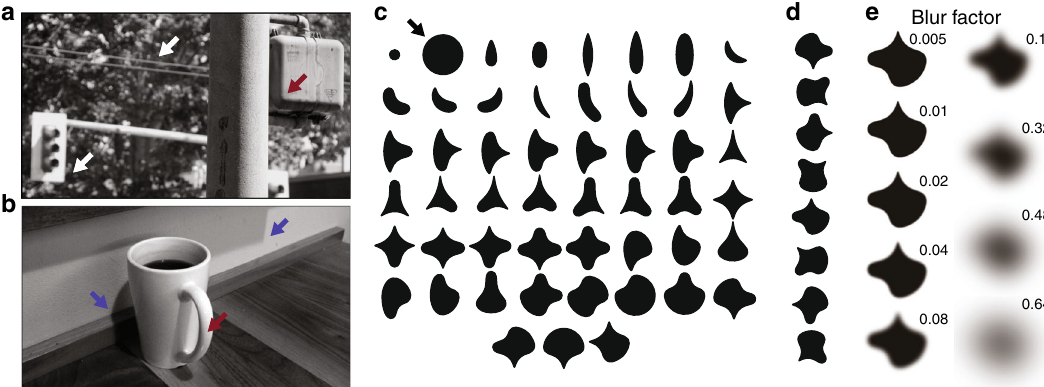
Fig. 1 Examples of blur in natural images and stimuli used to explore selectivity for shape and blur. a , b Examples of different types of blur in natural scenes. a Focal blur (white arrows) conveys information about depth while shading blur (red arrows) conveys information about 3D structure. b Penumbral blur is associated with cast shadows (blue arrows); during grouping, cast shadows do not interfere with perception of physical object boundaries and shading. c – e Stimulus set used to assess tuning for shape and blur in V4 neurons. c A standard set of 51 shapes were used to assess shape selectivity of V4 neurons. Stimulus size is de fi ned relative to the diameter of the large circle (black arrow). d Each shape was presented at up to 8 unique orientations at 45° increments; all rotations for one example shape are shown. For shapes with radial symmetry, duplicates were excluded. e To assess tuning for blur, a subset of preferred and non-preferred shapes were presented at up to 9 levels of Gaussian blur (see Methods: ‘ Visual stimulation ’ ). Example stimuli β ≥ 0.32 were cropped here for display